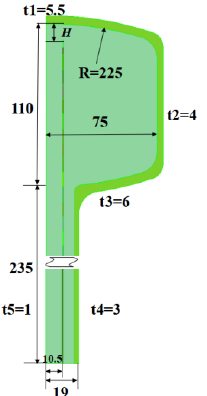
Figure 2. Calculation Domain (mm).